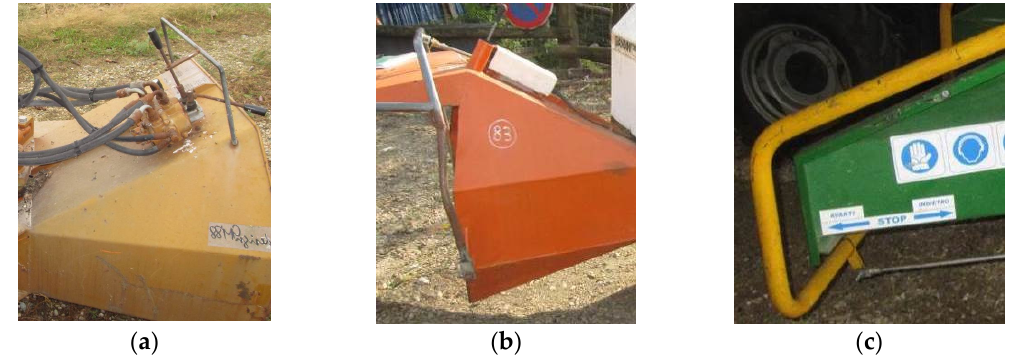
Figure 2. Examples of non ‐ compliant infeed controls for in ‐ use wood chipper. Details shown in figure ( a ) and ( b ) highlight the lack of any indication of machine operator controls; while figure ( c ) shows that the pictograms are placed in the correct position, but the functional requirements are not. Each of the examples included the reverse function but there was no “hold to run control” as requested by the paragraph 4.2.4.3 of the 6th revision draft of EN 13525.